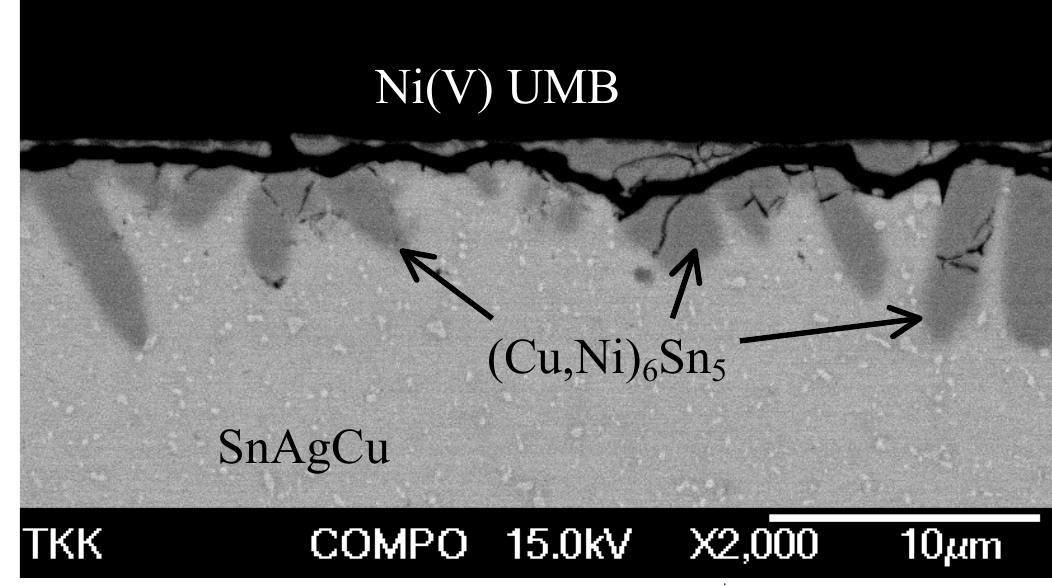
Sn reaction layer during drop 6 5